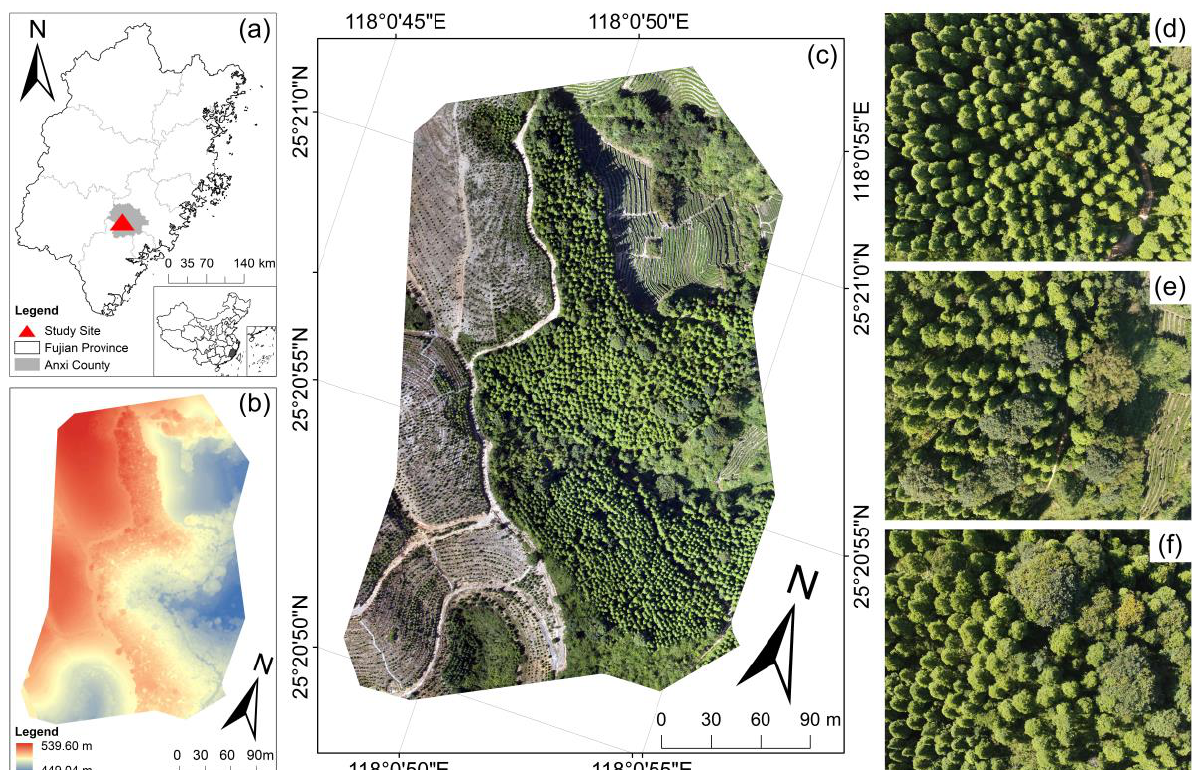
Figure 1. Location of the study site, Anxi County, Fujian, China. ( a ) study site in Anxi County, Fujian. ( b ) the digital surface model (DSM) derived from UAV. ( c ) UAV image. ( d – f ) are detailed examples of Fokienia hodginsii with other tree species.